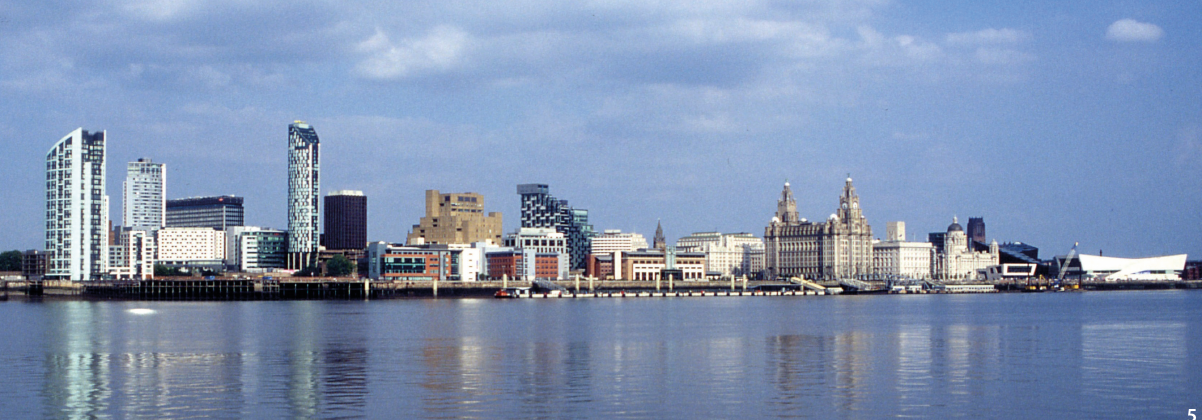
Figure 5 Liverpool Maritime Mercantile City, 2011: Panorama of the Merseyside waterfront from the seaward north-west. It was a core theme of the 2003 nomination document that the surviving urban landscape testifies to the historical role of Liverpool as a great port city and defines its ‘tangible authenticity’. The focal point, the Pier Head Group, popularly known as the Three Graces, ‘form a dramatic manifestation of Liverpool’s historical significance … [whose] vast scale … allows them to dominate the waterfront when approaching by ship’ (Liverpool City Council 2003). (Centre right: the Pier Head Group. Far right, the Museum of Liverpool, completed 2011. Left hand side: tall buildings constructed post-inscrip- tion.) (Source: Dennis